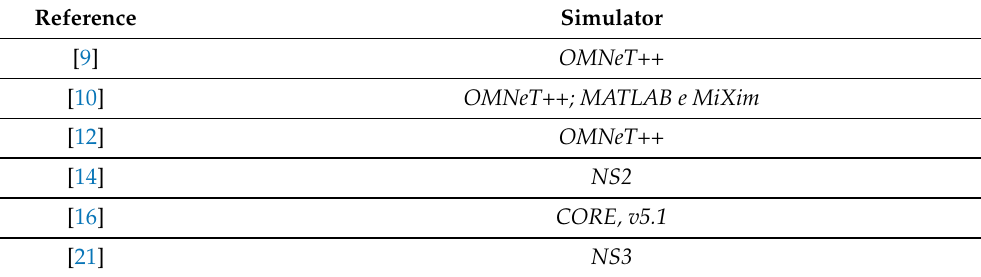
Table 7. Types of